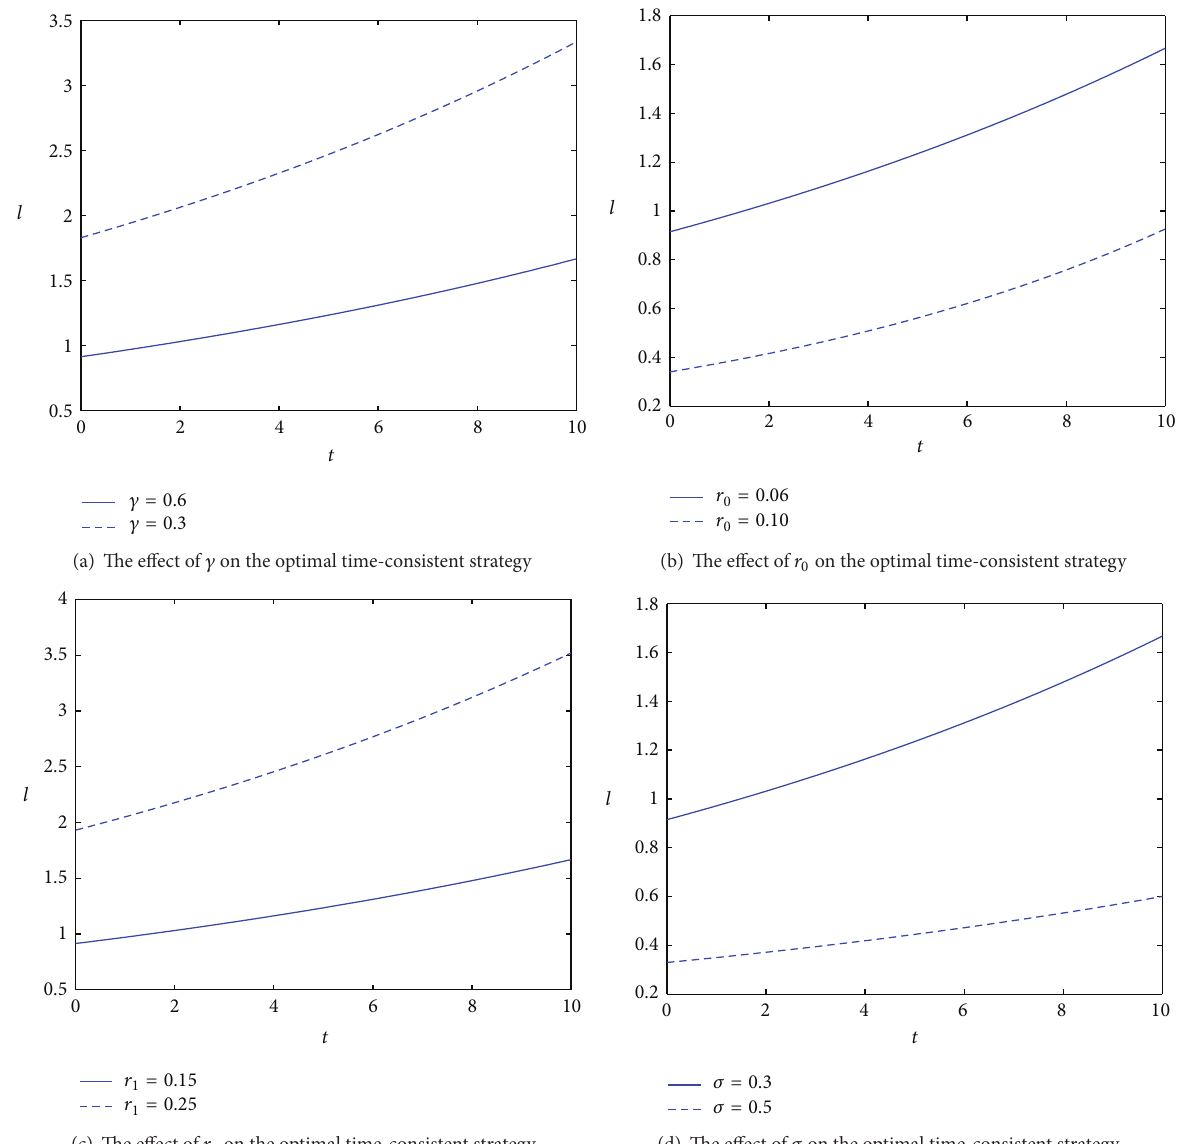
Figure 4: The effect of parameters on the optimal time-consistent